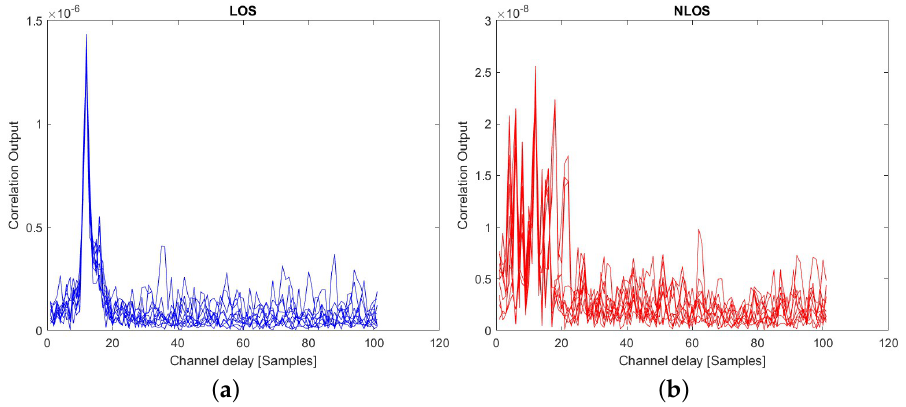
Figure 5. Examples of correlation outputs for PRS signals with WINNER II ( a ) LOS and ( b ) NLOS channels; 10 random realizations/channel at fixed SNR of 0